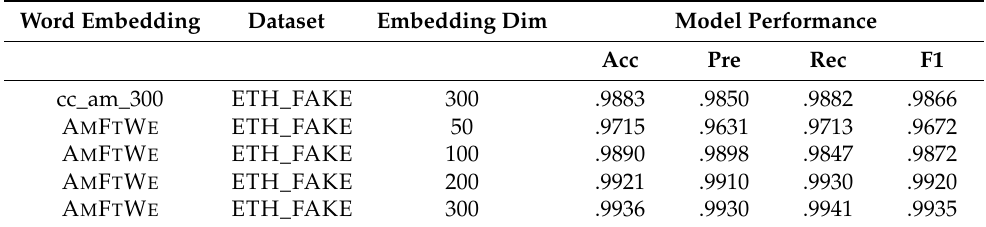
Table 5. Experimental result of the model performance using the cc_am_300 [10] and A M F T W e